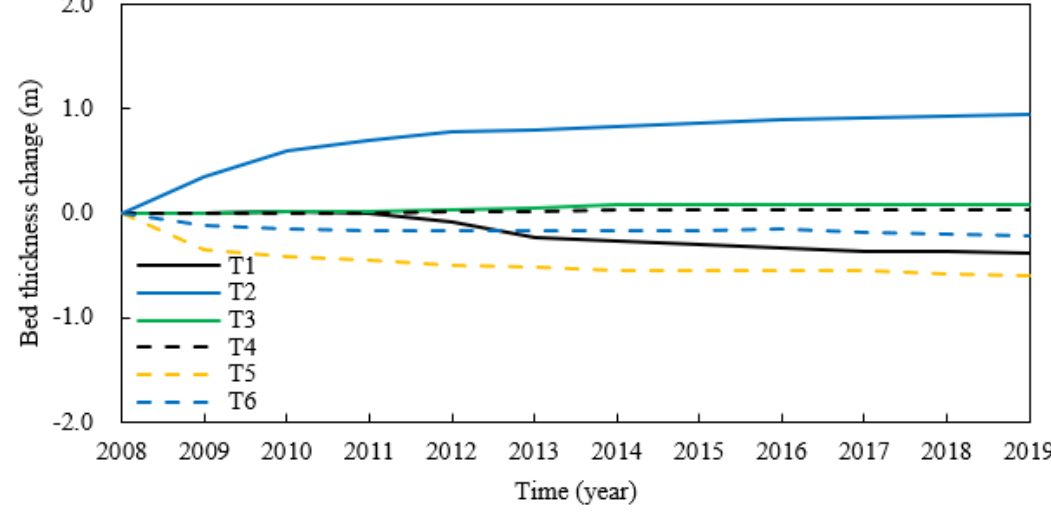
Figure 18. Bed thickness changes at the field observation stations T1 to T6 from 2008 to 2019.